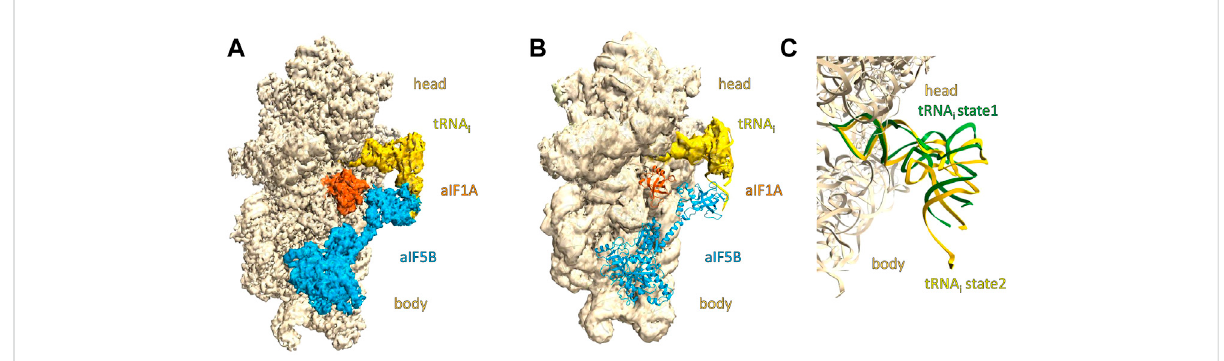
FIGURE 1 Overall view ofcryo-EM mapsofIC3 complexespreparedon gridscoming frombatch#3and batch#1. Thesmall ribosomal subunit 30S(made of the head and body parts) is colored in wheat, the tRNA is colored in yellow, aIF1A in orange, and aIF5B in cyan. 1A/3D density and corresponding model in the density of the IC3 complex containing the translation initiation factors aIF1A and aIF5B. 1B/3D density of the IC3 complex and correspondingmodellacking density fortranslation initiation factors aIF1AandaIF5B.1C/Close-upshowingthetRNA i conformationsobserved instructures 1Aand1B.Theviewwasobtainedafter superimpositionofthetRNAiconformationofthetwostructures.ThemodelforaIF1AandaIF5B have been omitted for better clarity. The tRNA i corresponding to the structure obtained in the IC3 complex lacking the translation initiation factors aIF1AandaIF5Biscoloredingreen.ThetRNA